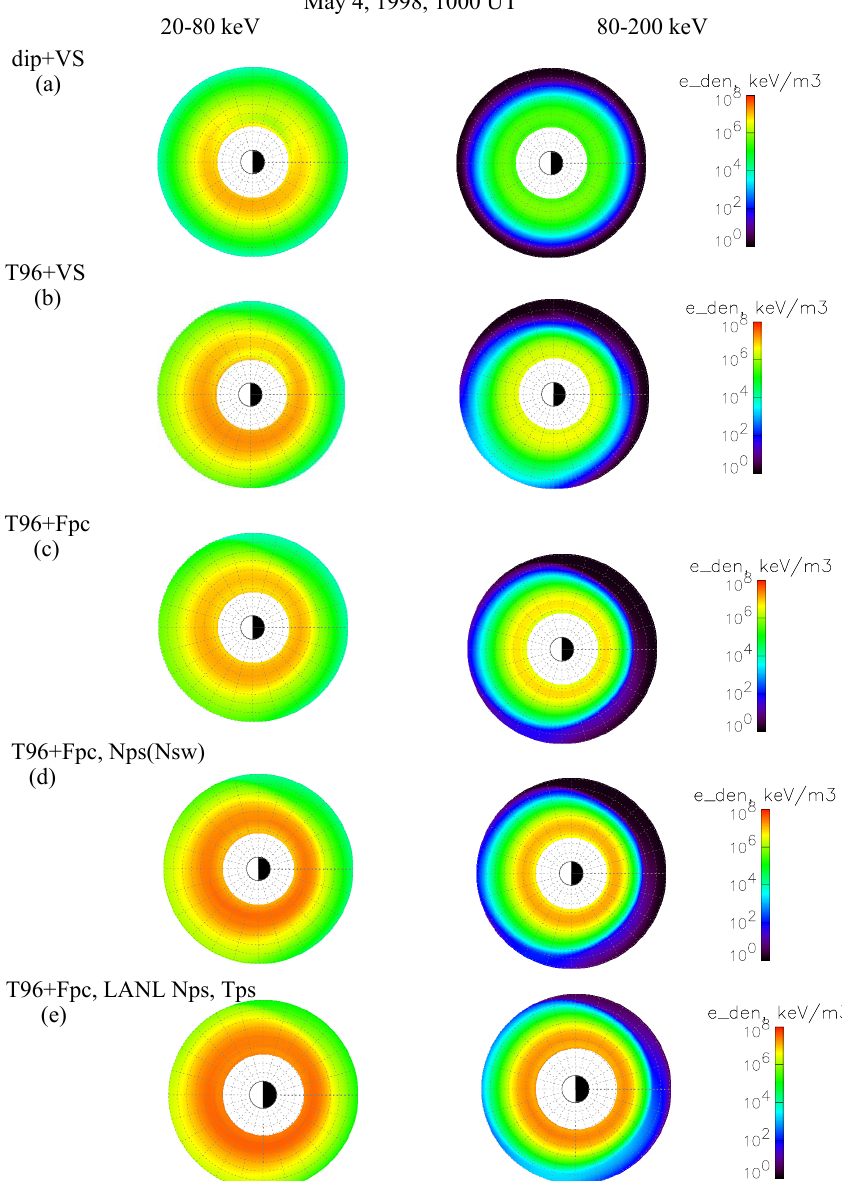
Fig. 7. Calculated energy density maps in the equatorial plane for protons with medium (20–80keV) energies and high (80–200keV) energies while tracing in 5 different combinations of field models and initial conditions similar to those shown in Figs. 5a–e during the recovery phase of 4 May 1998 storm at 10:00